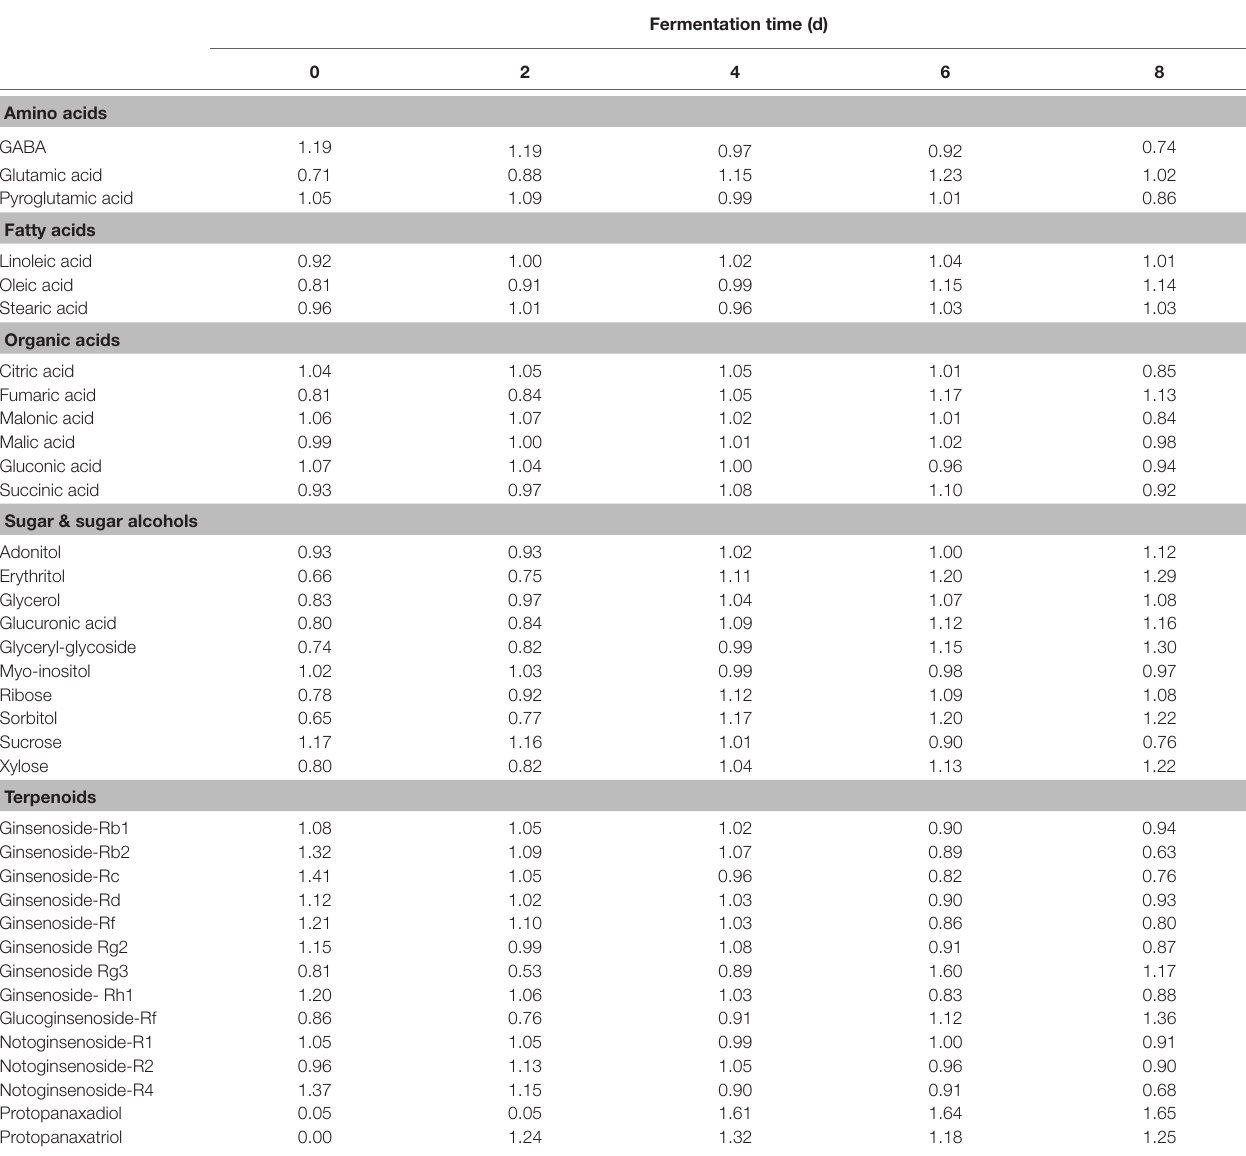
TABLE 1 | Relative distributions of metabolites analyzed by GC-TOF-MS and UHPLC-Q-orbitrap-MS in SSF-P (solid-state fermentation P. notoginseng ) fermented with A. cristatus.